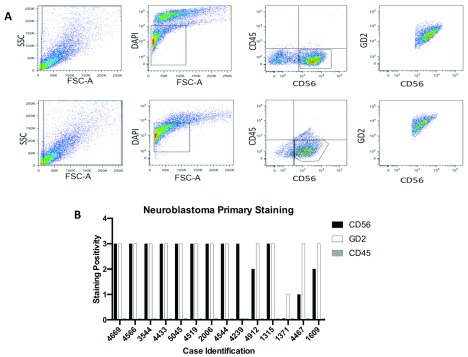
Neurospheres derived from neuroblastoma primary tumors retain typical immunophenotype.
A) representative flow cytometric staining for two independent cultures (excision culture 3544 (upper) and biopsy culture 4669 (lower) following gating on live cells.
B) graphical representation of the staining pattern in 14 evaluated samples; positivity was categorized into dim, medium and bright based on MFI and scored as 1, 2 and 3 respectively.